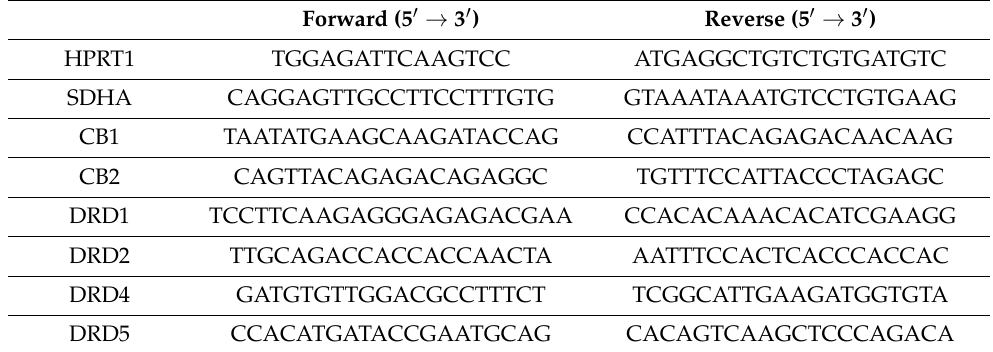
Table 1. The sequences of all the primers used for RTqPCR